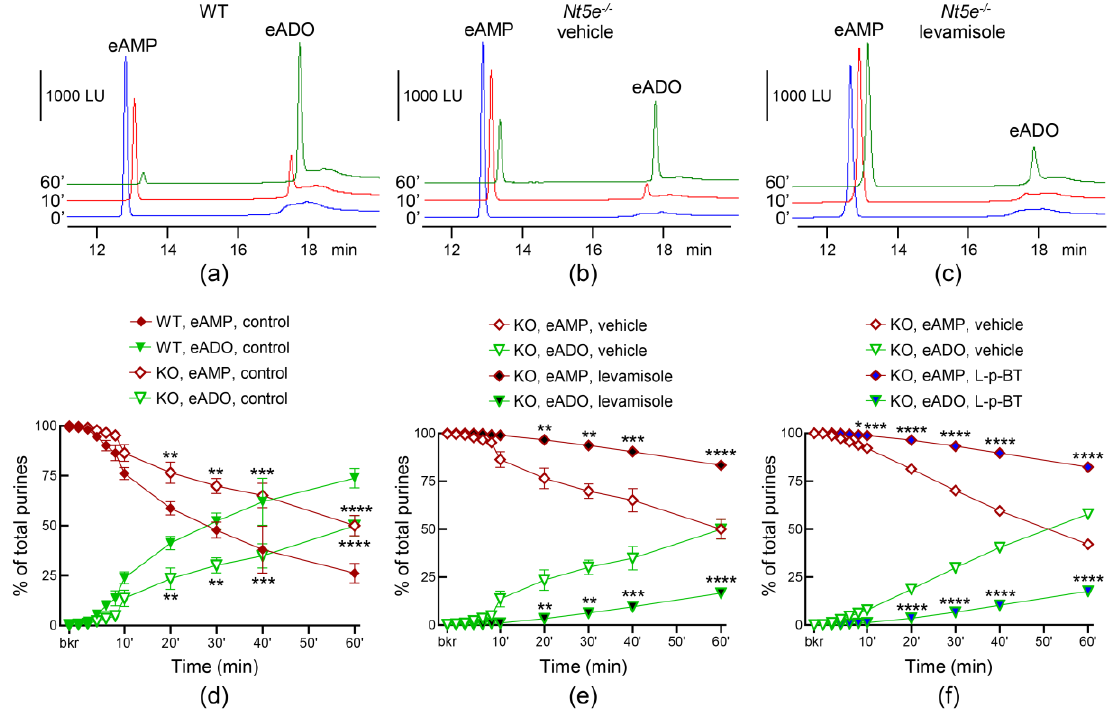
Figure 5. Hydrolysis of eAMP by soluble nucleotidases in the lumen of bladder preparations from WT and Nt5e −/− mice. Original chromatograms of eAMP in beaker (blue, 0 ′ , no enzymes pre- sent), at 10 min (red), and at 60 min (green) after starting the enzymatic reactions in ILS collected at the end of bladder filling from WT controls ( a ), Nt5e −/− controls ( b ) and Nt5e −/− preparations treated with levamisole (1 mM) ( c ). Summarized data showing time-courses of eAMP decrease and eADO increase in ILS from WT bladders ( n = 4 – 12) and from bladders isolated from Nt5e −/− mice ( n = 4 – 7) ( d ), in Nt5e −/− preparations filled with either vehicle (KBS) or levamisole ( n = 3) ( e ) or in Nt5e −/− blad- ders filled either with vehicle (DMSO 0.1%, n = 4) or L- p -BT (100 µM, n = 3) ( f ); n , number of bladder preparations. Note that the eAMP decrease and eADO increase were the greatest in WT prepara- tions and that the eAMP hydrolysis was significantly inhibited in the presence of either levamisole or L- p -BT. ** p < 0.01, *** p < 0.001, **** p < 0.0001 vs. controls. 2 way ANOVA with Sidak’s multiple